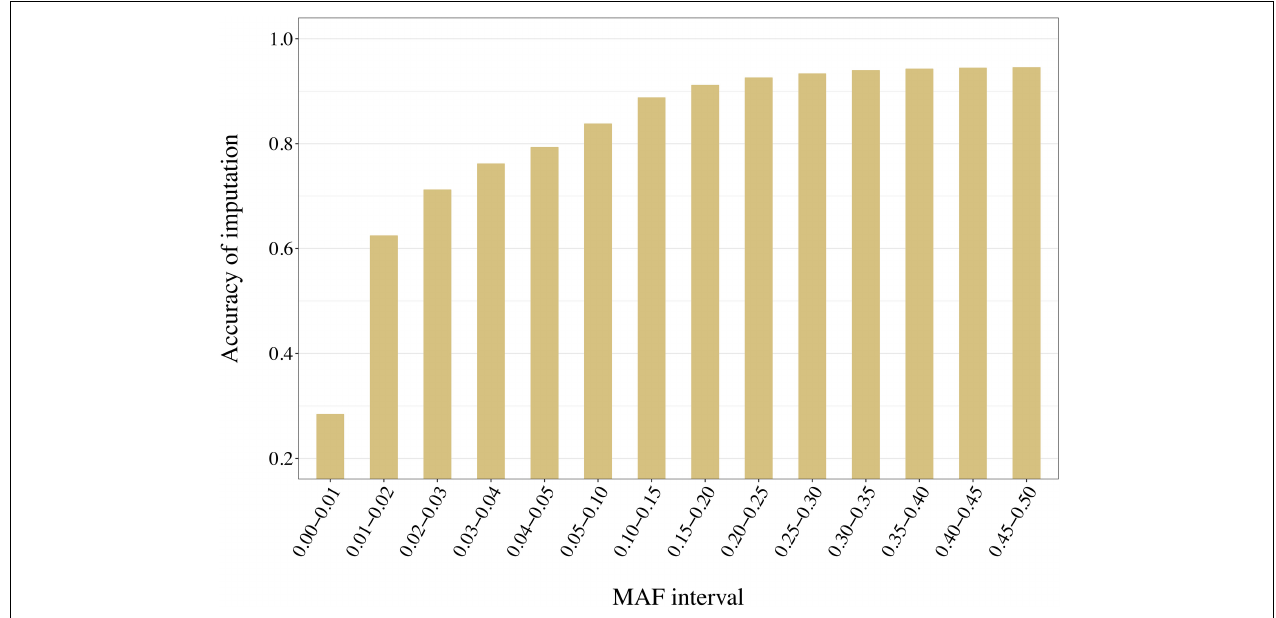
FIGURE 11 | Accuracy of imputation increases with higher minor allele frequency (MAF) of the variants. Here the accuracies reached with 50 animals in a reference group of key ancestors (AMAT) are presented. MAF bins “x-y” stands for “x < MAF ≤ y”. All standard errors are below